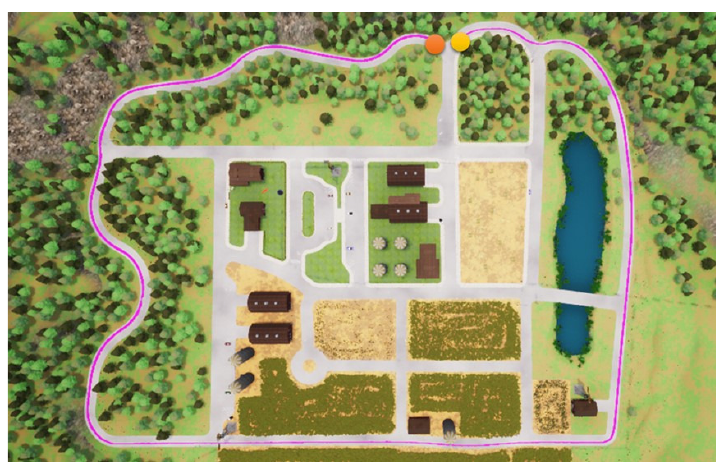
Figure 19. RDPG with a semantic segmentation camera for the second testing